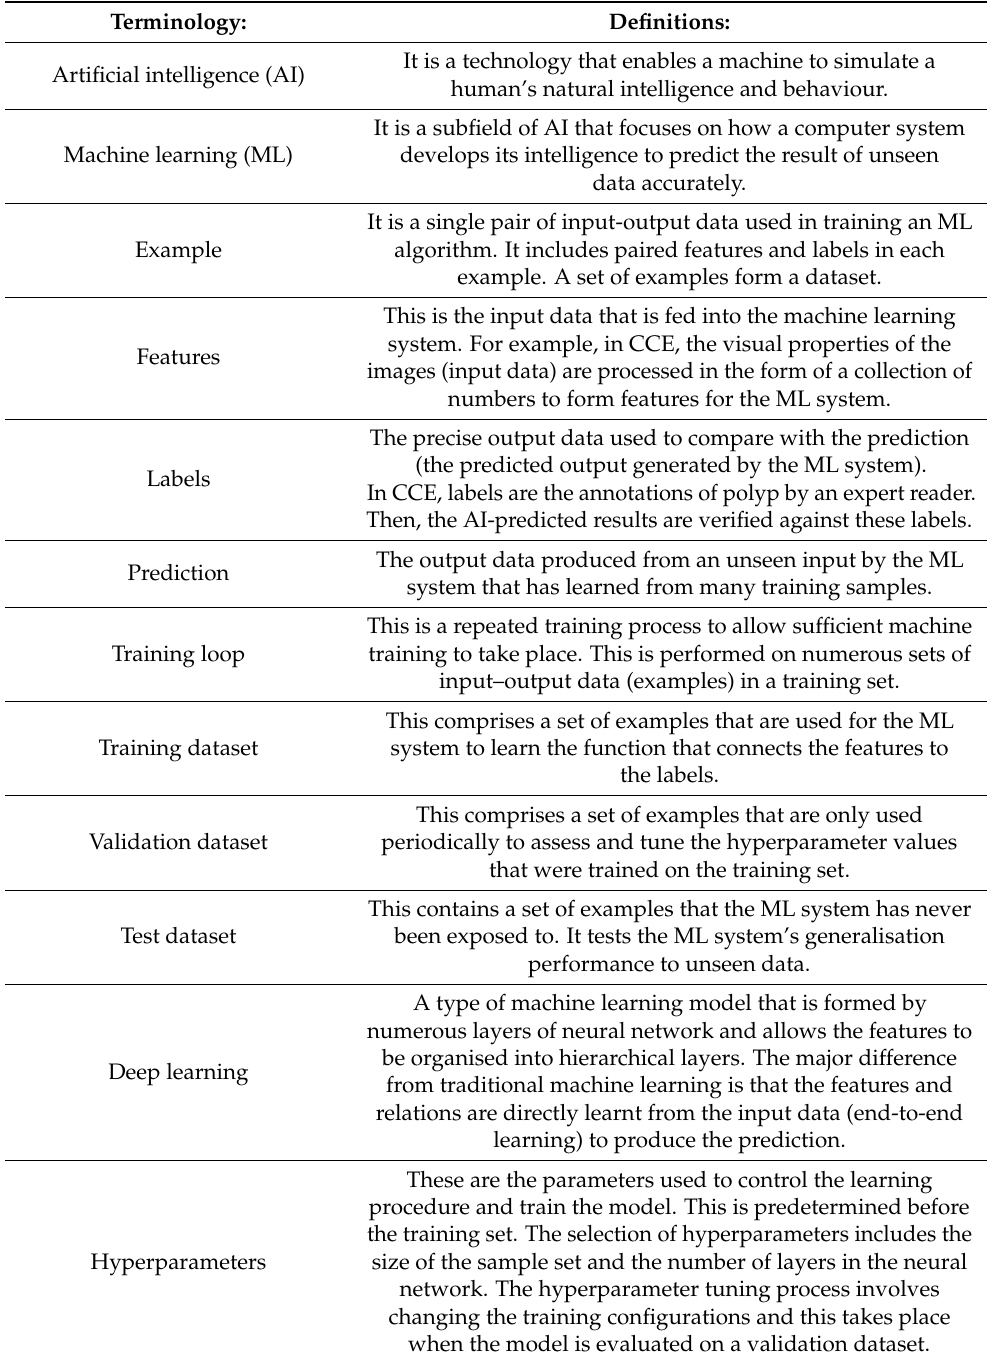
Table 1. Relevant technical terminology in machine